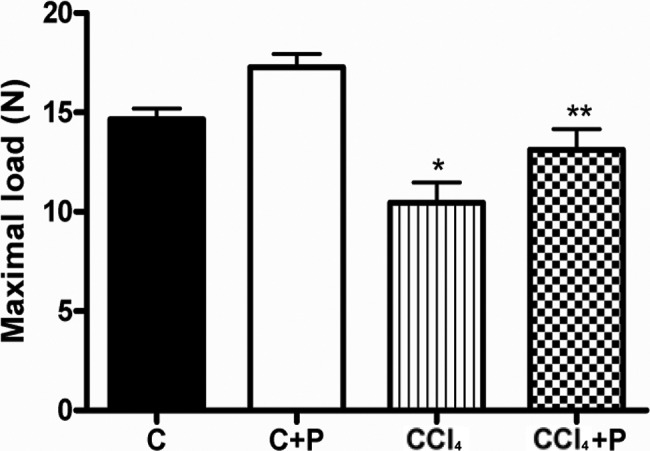
Maximum force attained in the four groups (C, C+P, CCl4, and CCl4+P). * CCl4 < C, C+P, and ** CCl4+P < C+P, p<0.05.